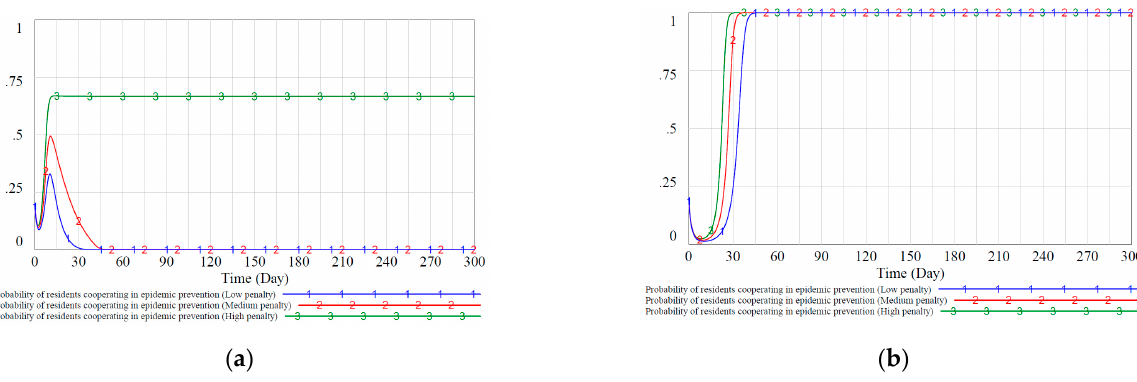
Figure 8. Proportion of residents’ evolutionary stable equilibrium strategies under static and dynamic punishment scenarios. ( a ): probability of residents cooperating in epidemic prevention in different penalty intensities under the static mechanism. ( b ): probability of residents cooperating in epidemic prevention in different penalty intensities under the dynamic